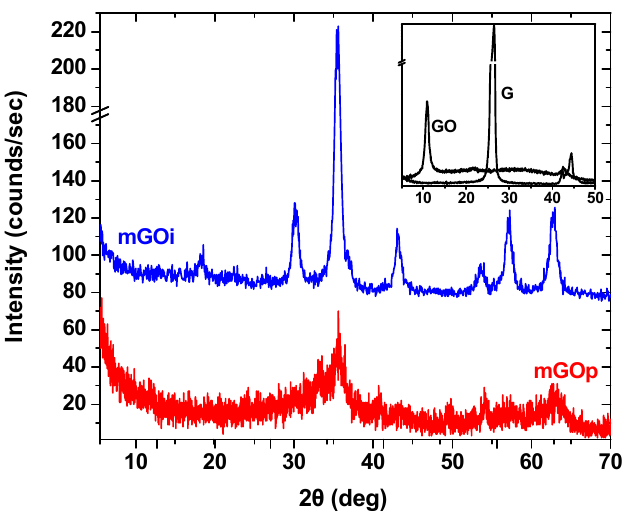
Figure 2. X-ray diffraction (XRD) patterns of mGOi and mGOp (Inset: XRD patterns of GO and